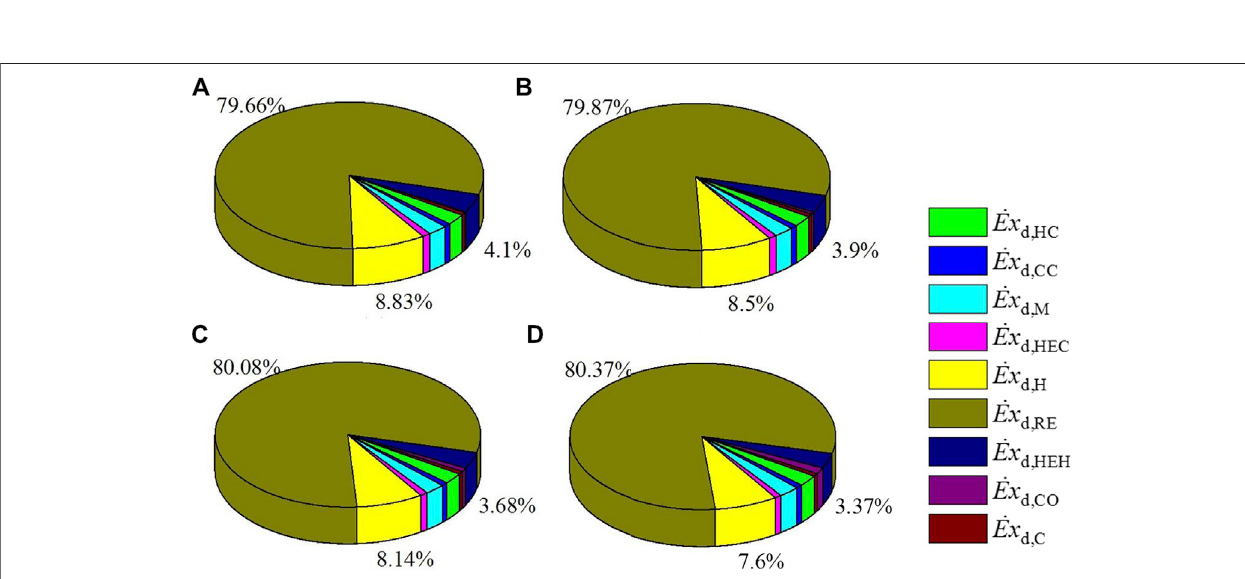
FIGURE 6 | Distribution proportion of exergy destruction for each components under different reaction temperatures, (A) 483.15K, (B) 503.15K, (C) 523.15K, (D) 543.15K.